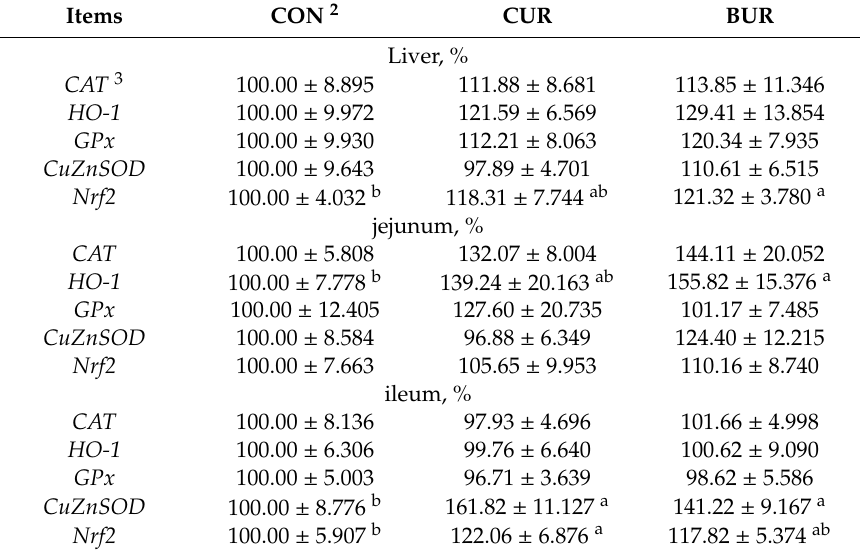
Table 6. E ff ect of curcumin and bisdemethoxycurcumin on the antioxidant gene expression of liver, jejunum and ileum in broilers (Experiment 2) 1